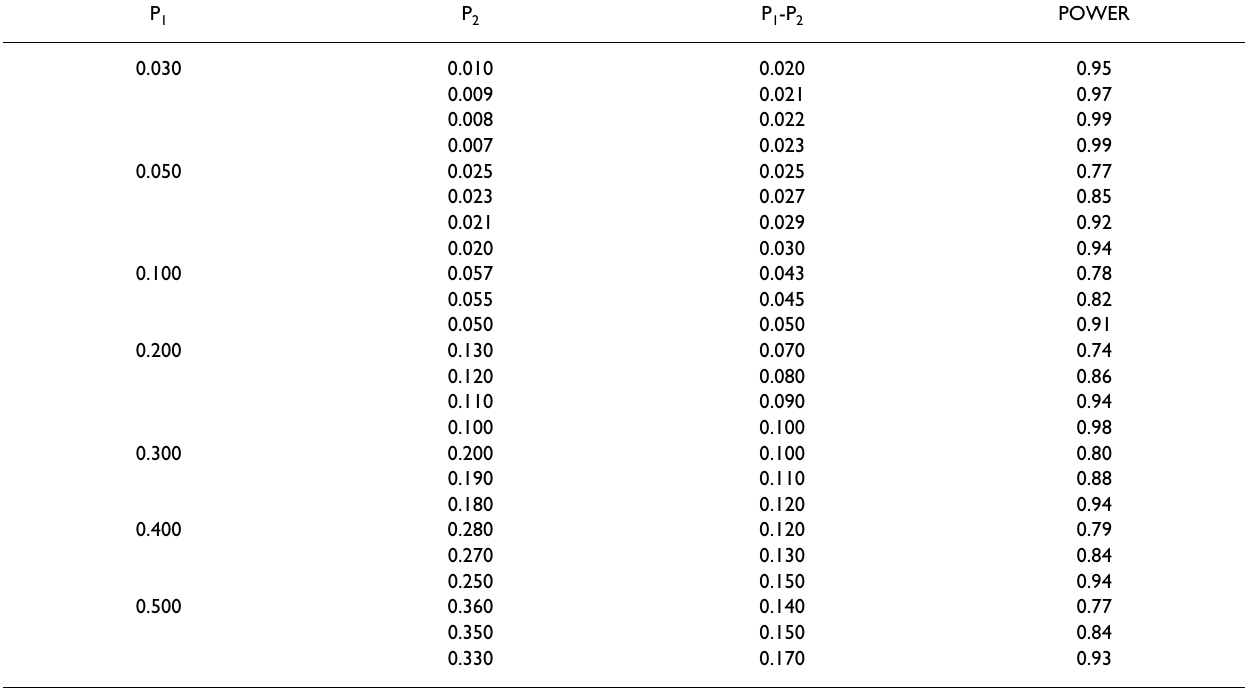
Table 2: Power to detect the difference between the genotypic distributions in two populations, assuming a sample of 230 from population 1 (cases) and 400 from population 2